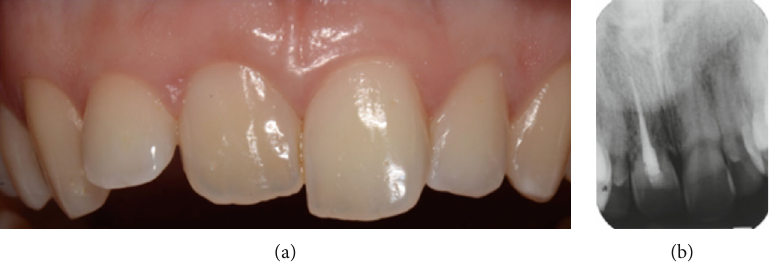
Figure 4: (a) Clinical and (b) radiographic view of the upper incisor at the 8-year follow-up visit: tooth infraposition and root resorption are evident.